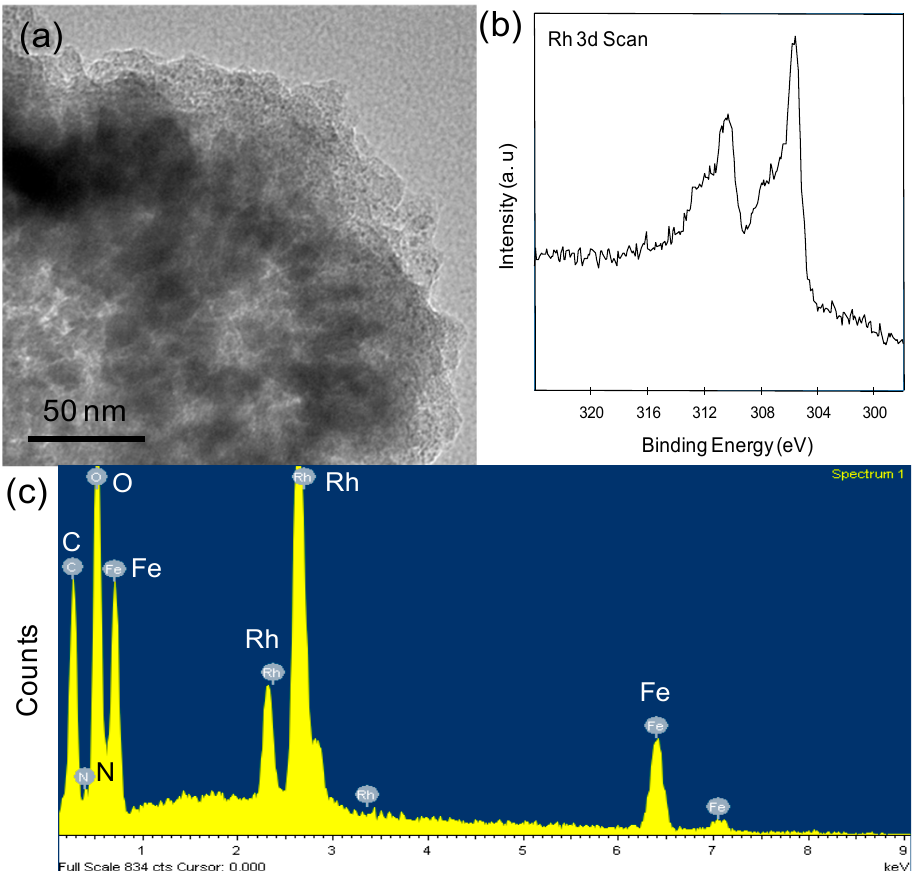
Figure 7. ( a ) TEM images of magnetically-recyclable hollow nanostructured Rh catalyst; ( b ) XPS analysis of Rh 3d scan; ( c ) EDX spectrum of magnetically-recyclable hollow nanostructured Rh catalyst. Reprinted with permission from